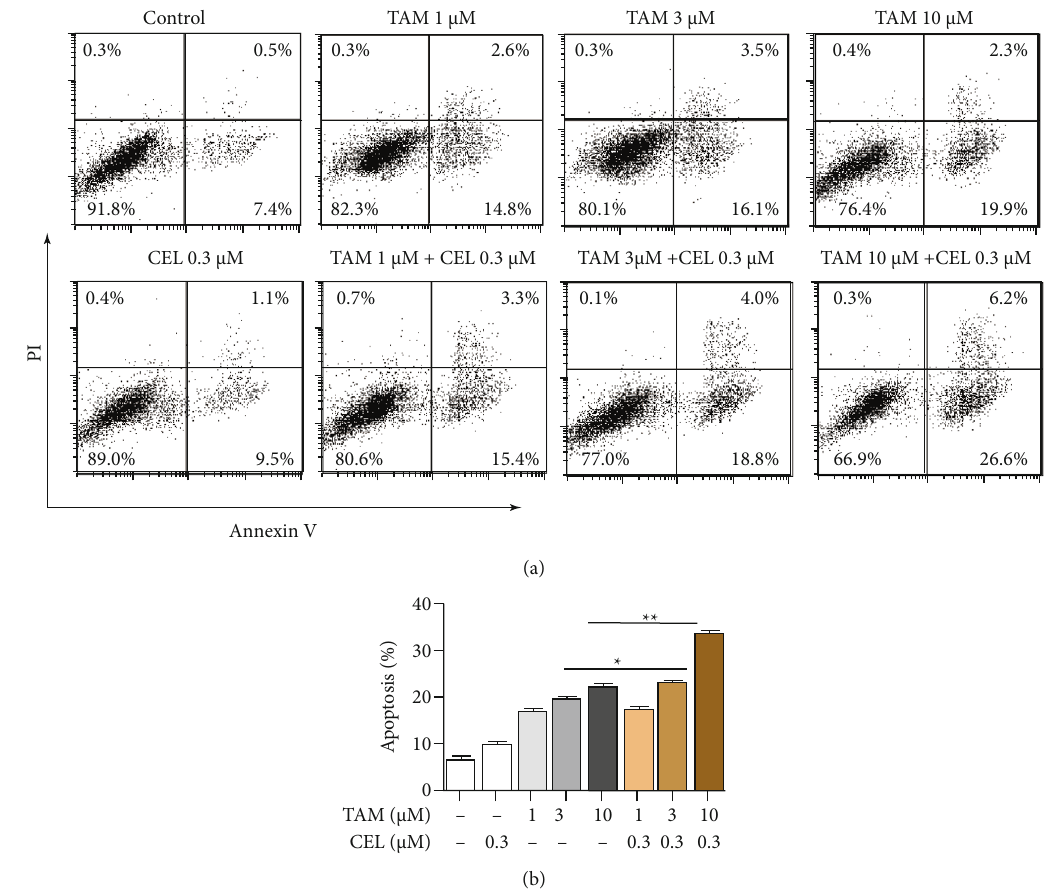
Figure 3: E ff ects of tamoxifen, celastrol, and the combination of tamoxifen and celastrol on apoptosis in MCF-7 cells. After treatment with celastrol (0.3 μ M), TAM (1, 3, and 10 μ M), and the combination for 24 hours, cell apoptosis was detected. The lower concentration of celastrol (0.3 μ M) did not increase apoptosis in MCF-7 cells; the medium-high concentration of TAM (3, 10 μ M) signi fi cantly increased the apoptosis rate of MCF-7 cells, and even the addition of celastrol at a lower concentration signi fi cantly increased cell